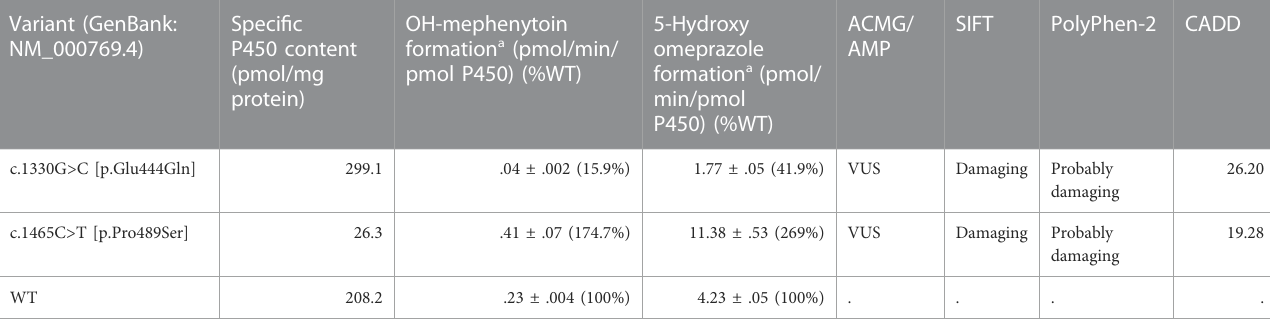
(Figure 2; Table 3). Immunoblot results identi fi ed suf fi cient